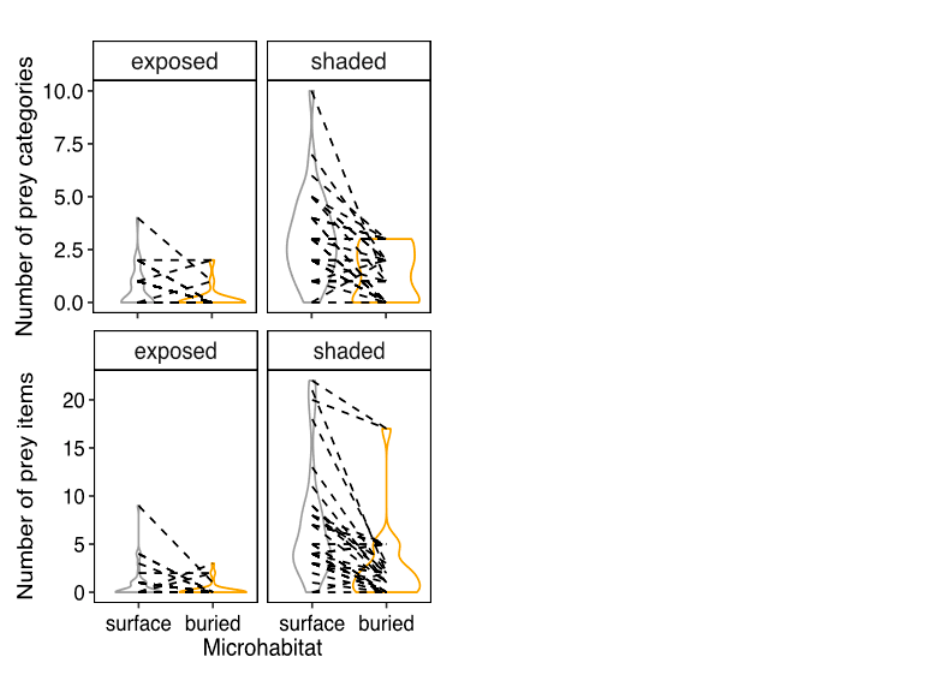
Figure 4. ( Upper row ). Comparison of predatory performance between 5 BSLM and 5 lacertoid spe- cies eating uninjured and leg injured crickets during a 24 hours experiment. ( Lower row ). Results of an analogous experiment (134 observations) on the same species but comparing lizards’ capabil- ity of hunting on surface prey vs. prey located under sand (termites). Colored lines connect the mean values of the same species in each treatment.